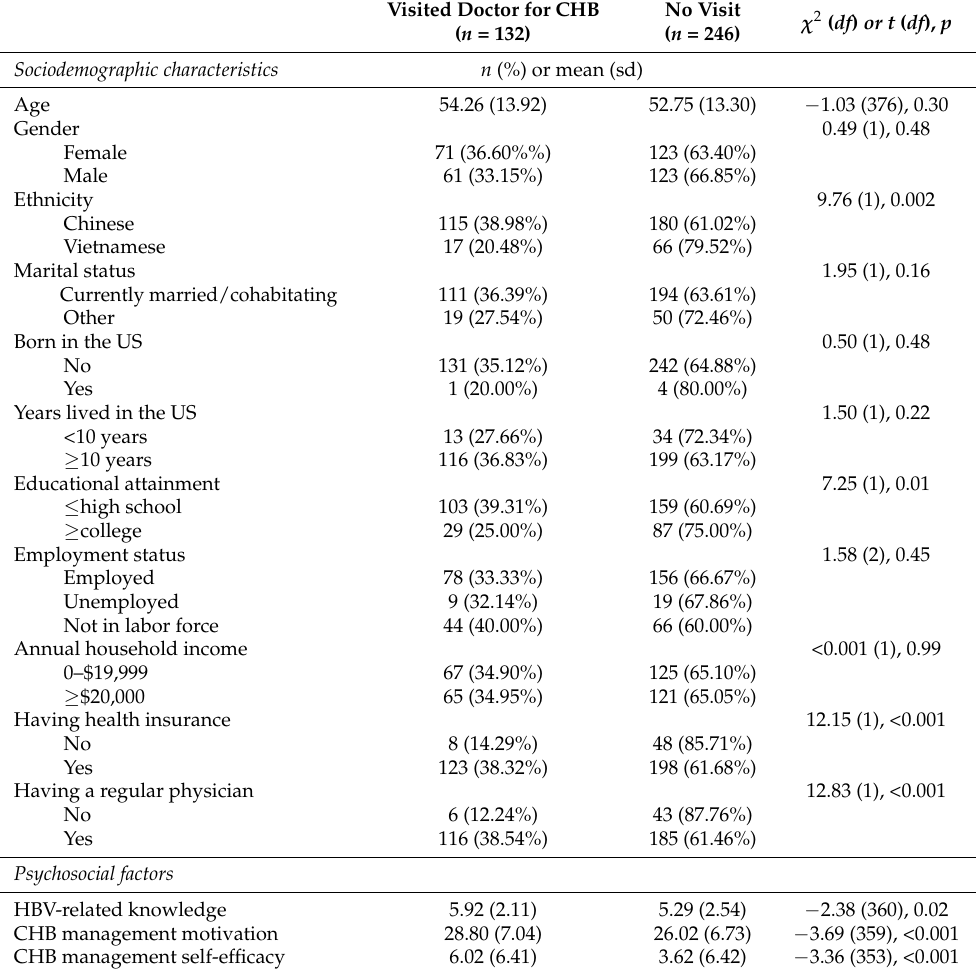
Visited Doctor for CHB No Visit χ 2 ( df ) or t ( df ), p ( n = 132) ( n = 246)